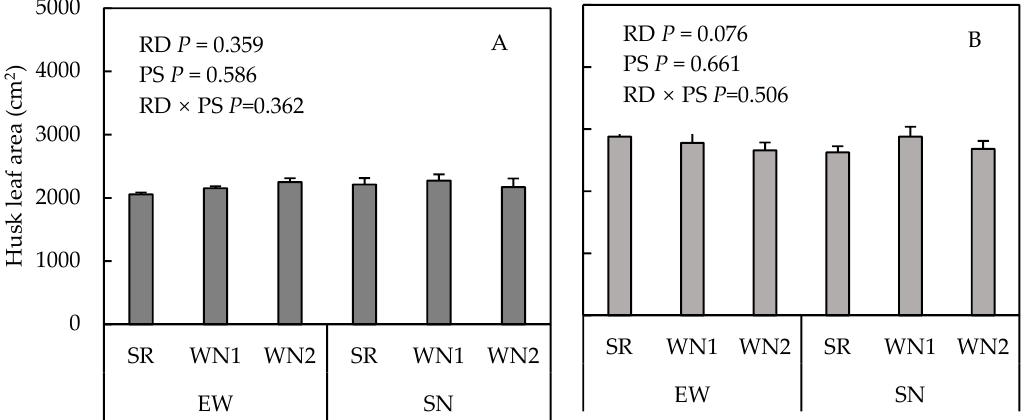
Figure 2. Area of husk maize leaf under two row directions (RD) and three plant spacings (PS) in 2015 ( A ) and 2016 ( B ) (EW and SN indicate the row direction of east to west and south to north, respectively. SR indicates single rows spaced at 65 cm; WN1 indicates 40 cm twin rows spaced at 90 cm between the paired rows of narrow–wide rows; and WN2 indicates 40 cm twin rows, spaced at 160 cm between the paired rows of narrow–wide rows.). Bars denote the SE of the mean ( n = 3).